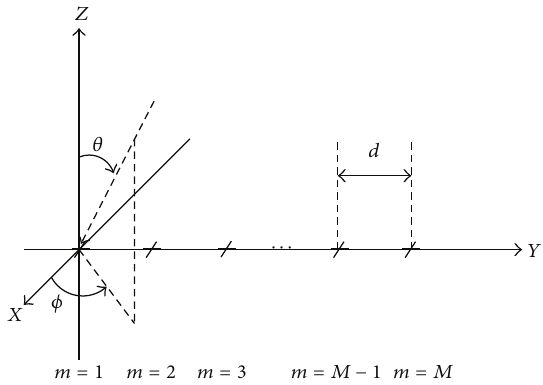
Figure 1: Array model being considered with crossed dipole